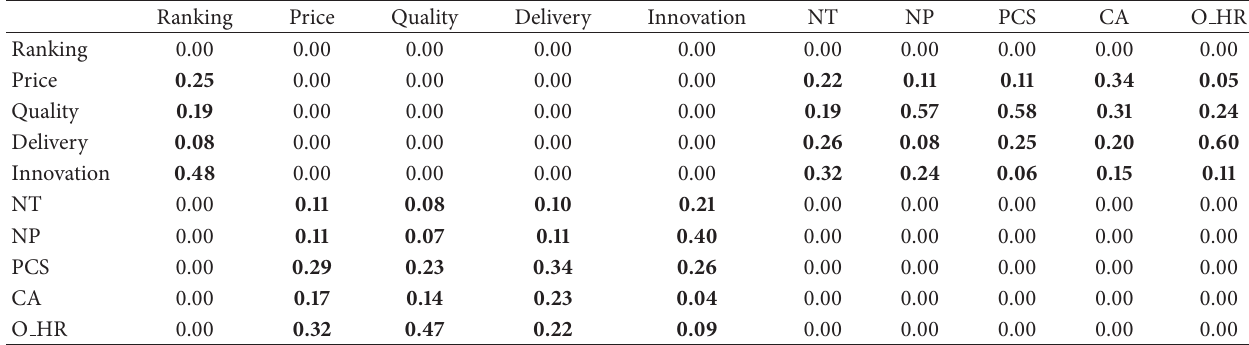
Table 8: Normalized supermatrix of decision agent 5.